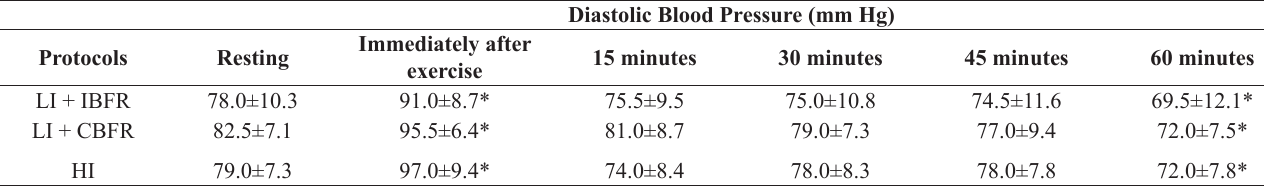
Table 2. Comparative analysis of diastolic blood pressure between the study protocols.